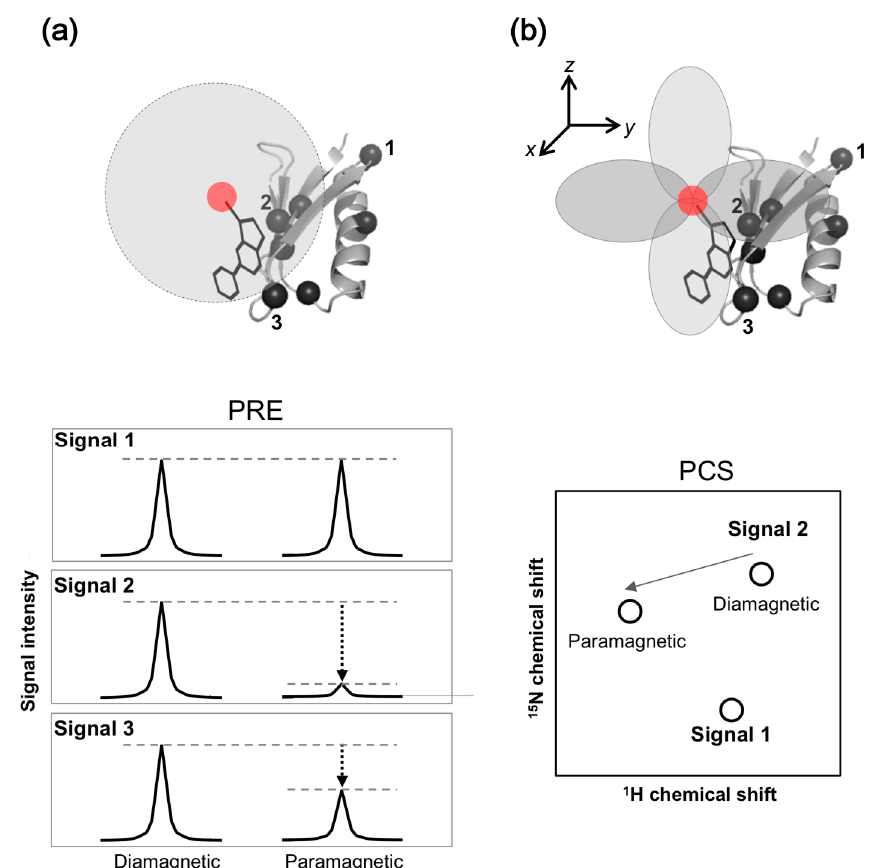
Figure 3. Paramagnetic effects utilized for protein-based NMR approaches for SBDD studies. Effects of ( a ) paramagnetic relaxation enhancement and ( b ) pseudo-contact shift are illustrated. Paramagnetic center denoted with red sphere is chemically immobilized on the ligand or protein. Black spheres on the protein indicate position of isotopically-labeled moieties. Numbers correspond to each NMR signal. ( a ) The changes of signal intensity of protein are induced by paramagnetic effect depending on the distance between paramagnetic center and position of isotopically-labeled moieties. ( b ) The changes of chemical shift of protein depend on the distance between paramagnetic center and position of isotopically-labeled moieties, and at an angle with magnetic field.